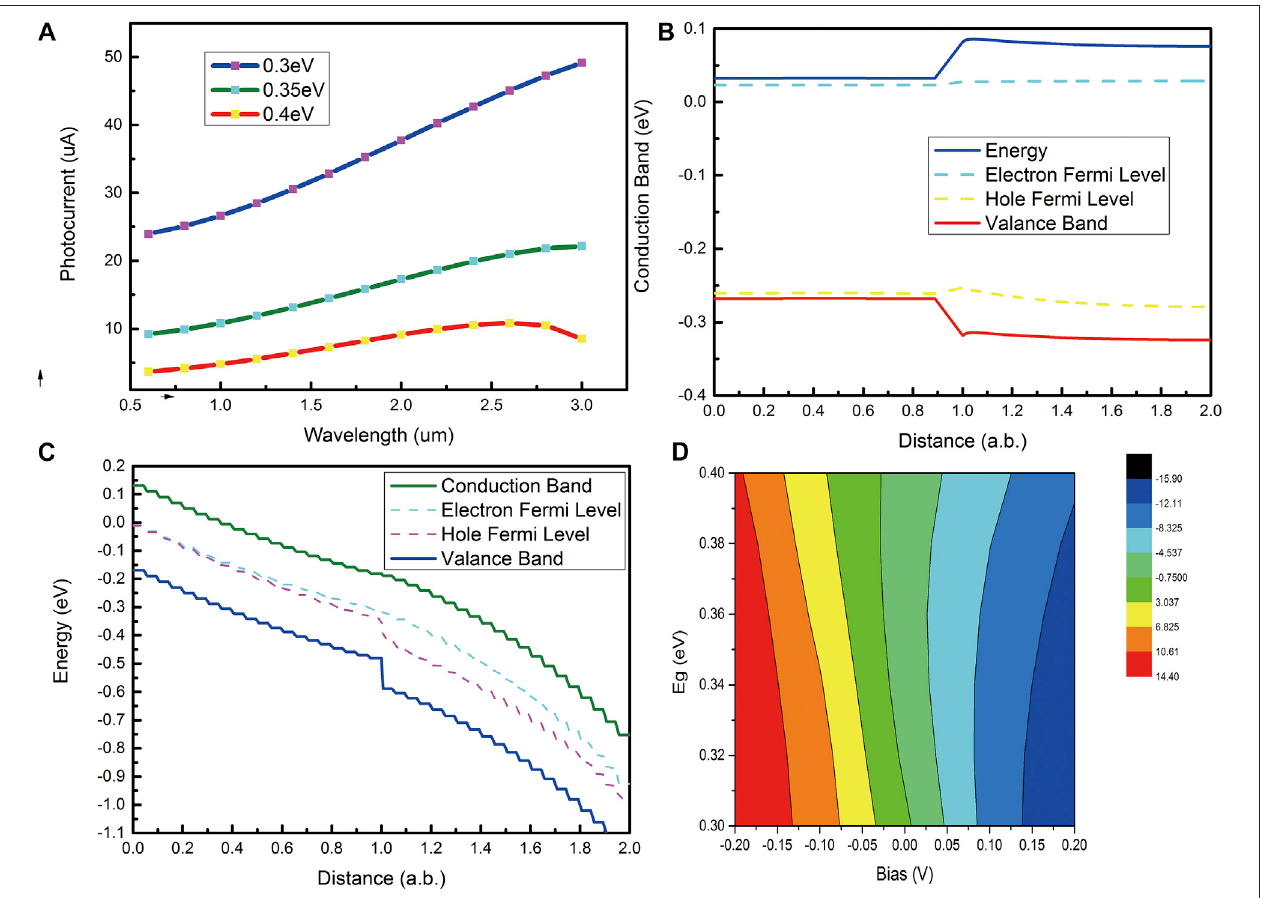
FIGURE3| TCADmodelingresultofasymmetricBP. (A) PhotocurrentofasymmetricBPwithdifferentbandgap. (B) TheenergybanddiagramofundopedBP. (C) Energy diagram of p asymmetric BP with different p doping. (D) Photocurrent as a function of bias voltage and band gap of asymmetric BP.